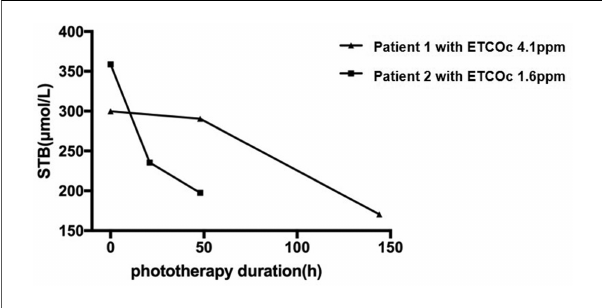
FIGURE 2 Dynamic changes in STB (serum total bilirubin)in two patients. Patient 1 was a full-term neonate (GA, 41 weeks and 2 days) with a BW of 3450 g. His ETCOc level was 4.1 ppm. After about 48 h of phototherapy, the STB decreased to 290.5 µmol/L. After 144 h of phototherapy, the STB was 170.6 µmol/L. Patient 2 was born at a GA of 39 weeks and 5 days with a BW of 3450 g. He was admitted with an STB of 358.8 µmol/L and an ETCOc of 1.6 ppm. After 21 h of phototherapy, the STB decreased to 235.5 µmol/L. After 48 h of phototherapy, the STB decreased to 197.5 µmol/L. STB, serum total bilirubin; GA, gestational age; BW, birth weight; ETCOc, end-tidal carbon monoxide corrected to ambient carbon